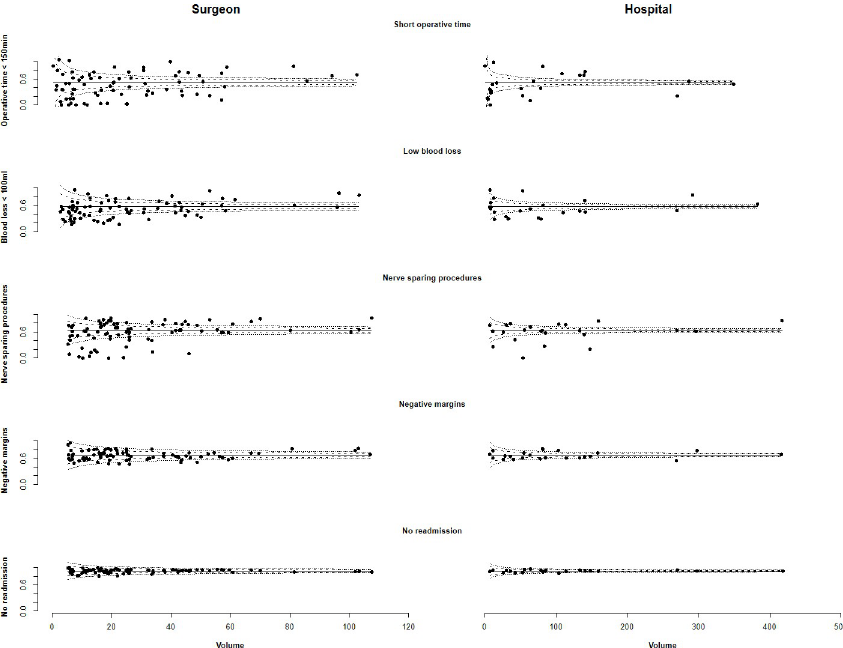
Fig 3. Adjusted proportions of RARP with outcome according to surgical volume by single surgeon and hospital. Mean proportion and 95% and 99.9% CI for the whole data set also displayed. Mean number of RARP/year performed by each surgeon and in each hospital is shown on the